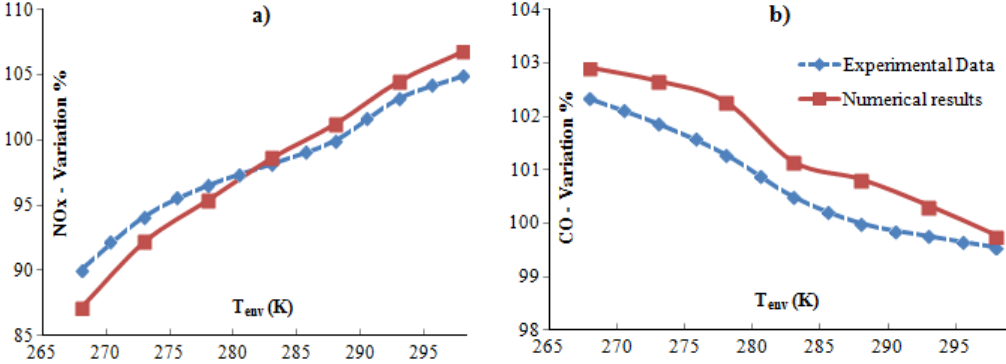
Figure 5. ( a ) NO and ( b ) CO percentage variation for different environmental x